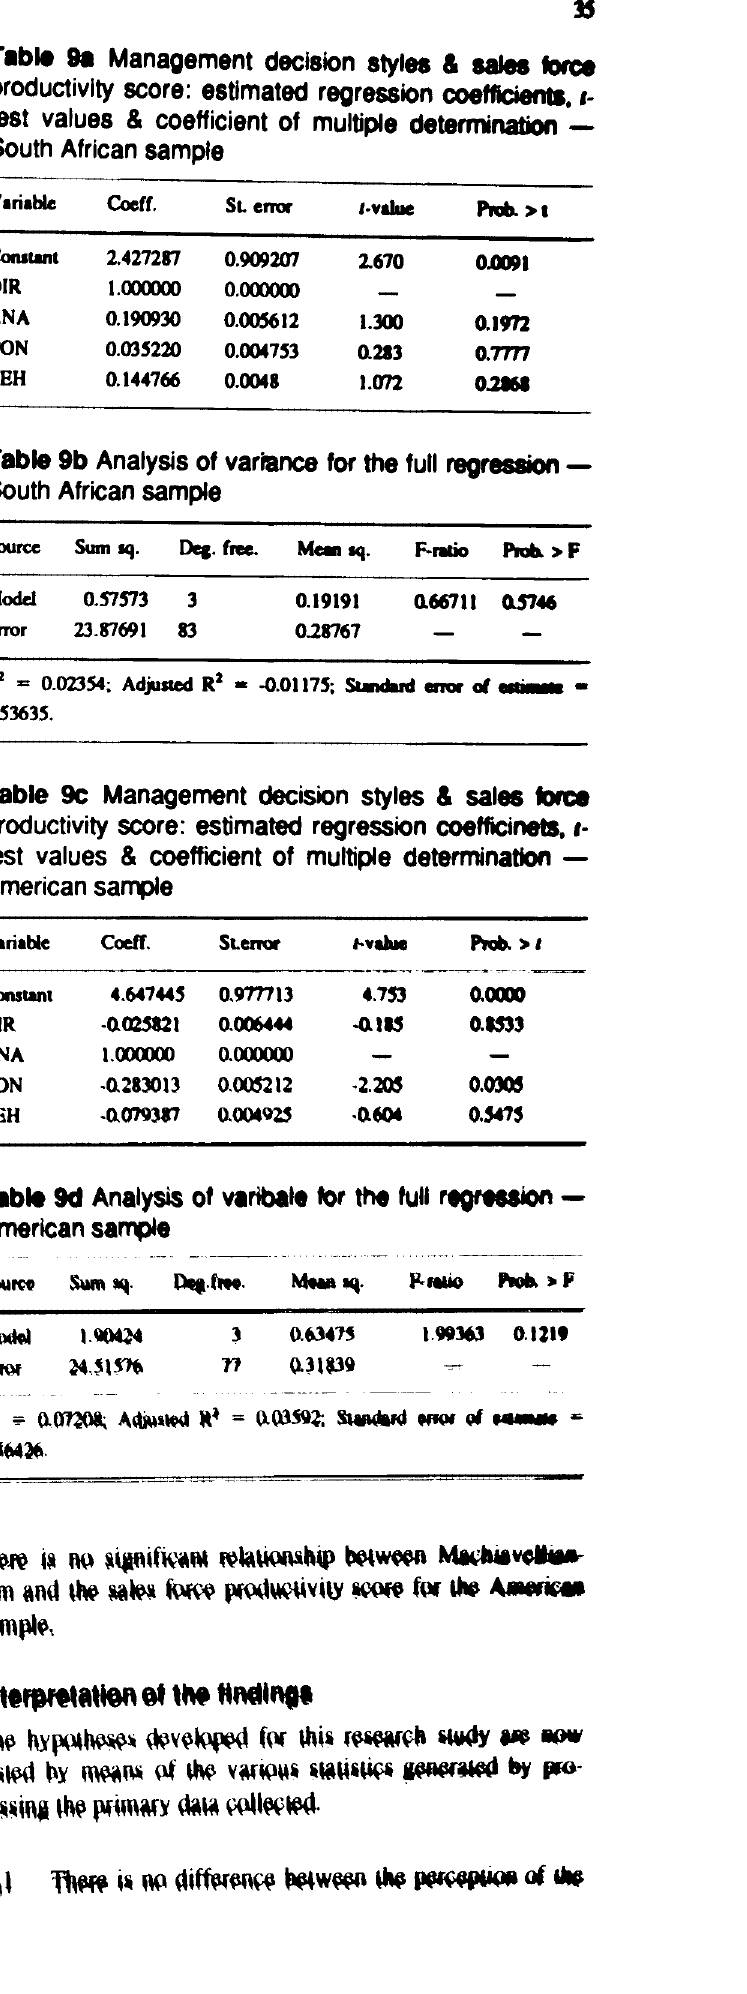
Table 9a Management decision styles & sales force productivity score: estimated regression coefficienla, ,_